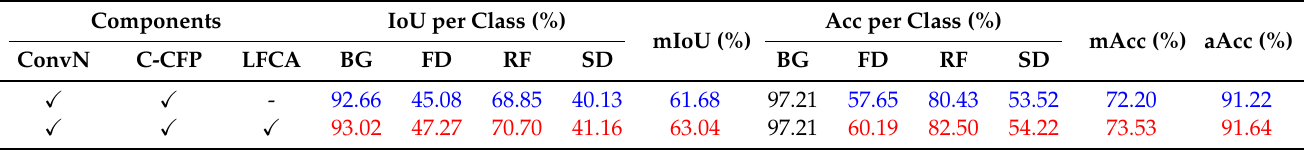
Table 5. The performance of the network after joining LFCA.